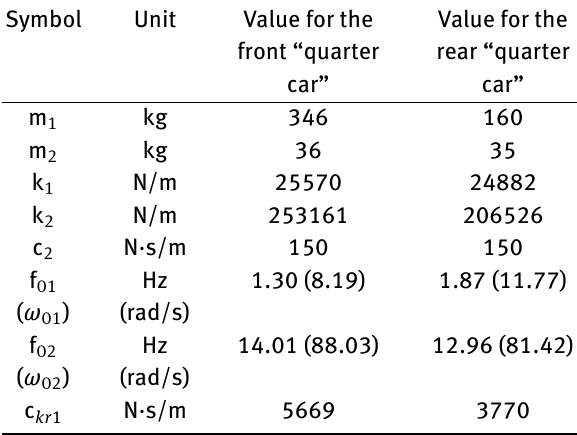
Table 1: Parameters of the linear model Symbol